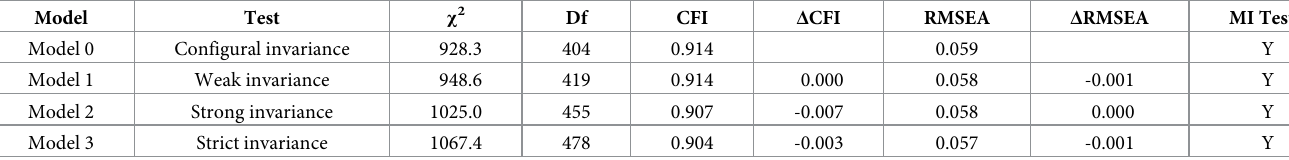
Table 5. The analysis of factorial invariance for gender using multi-group confirmatory factor analysis.